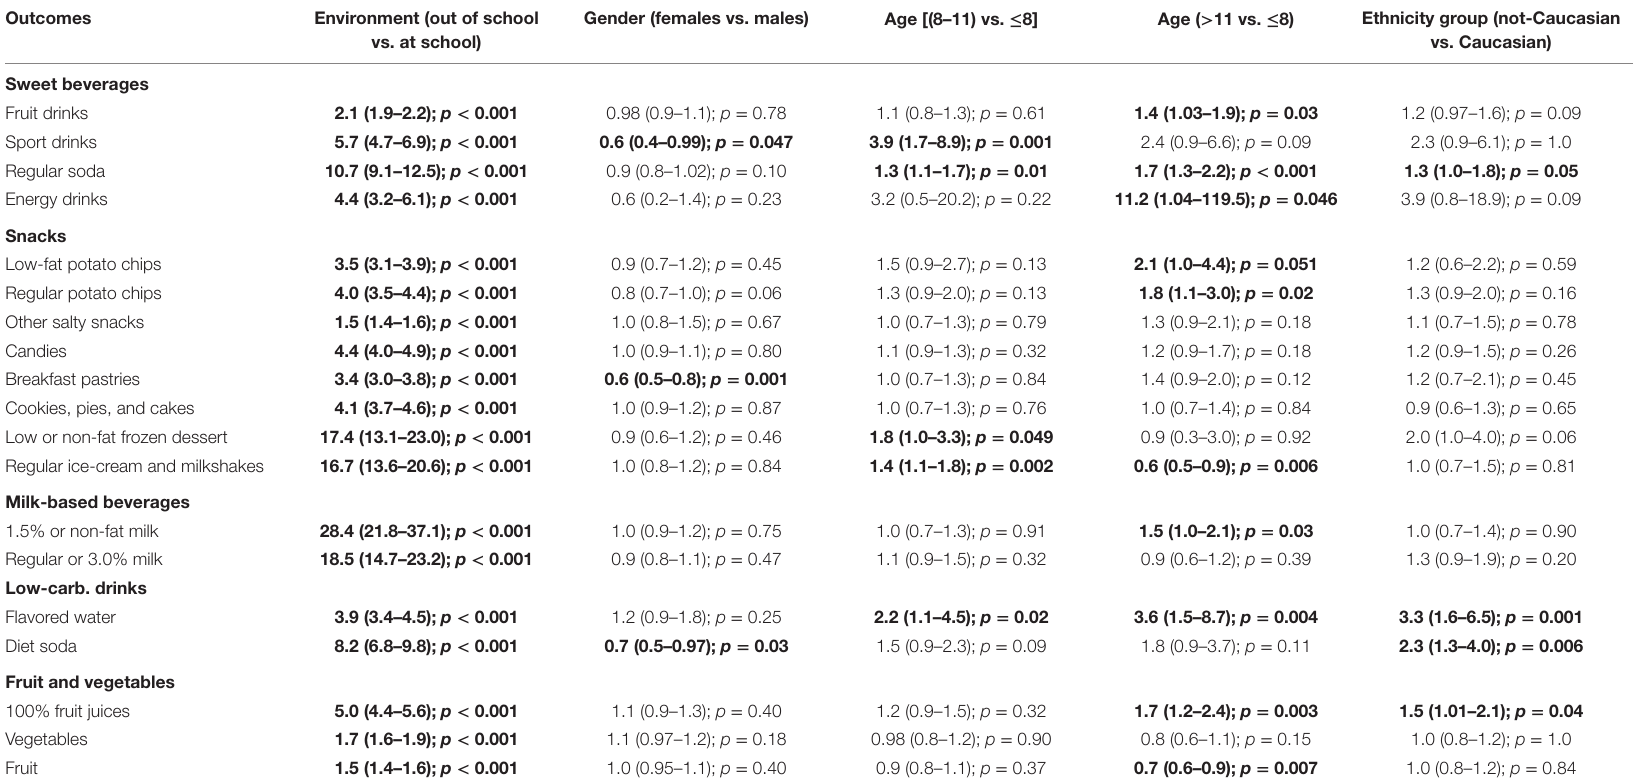
*Obtained through three-level Poisson Models with random intercept and with students (level 1 units) nested into classroom (level 2 units) nested into schools (level 3 units). Values describe the difference expressed in terms of IRR with the relative 95% CI and p-value, between covariates (environment, gender, class of age, and ethnic group) and outcomes in terms of weekly/daily consumption. In bold, IRRs statistically significant; only p-values < 0.05 were reported in